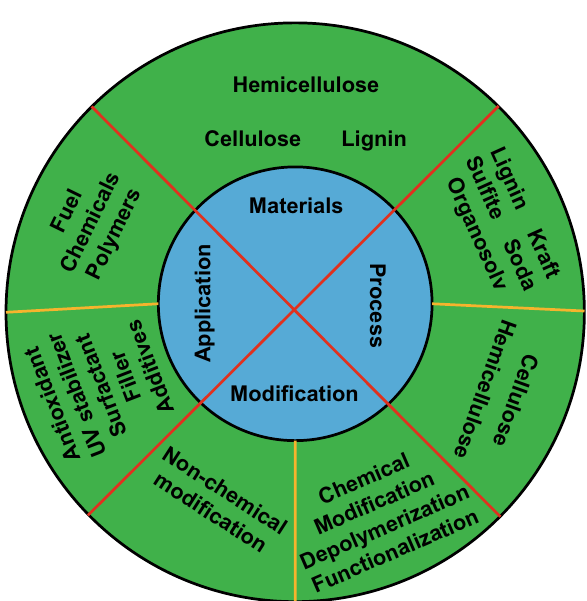
Fig. 4 Schematic representation of the main processes for lignin extraction and possible chemical modifications performed in order to valorize lignin, depending on the applications [66]